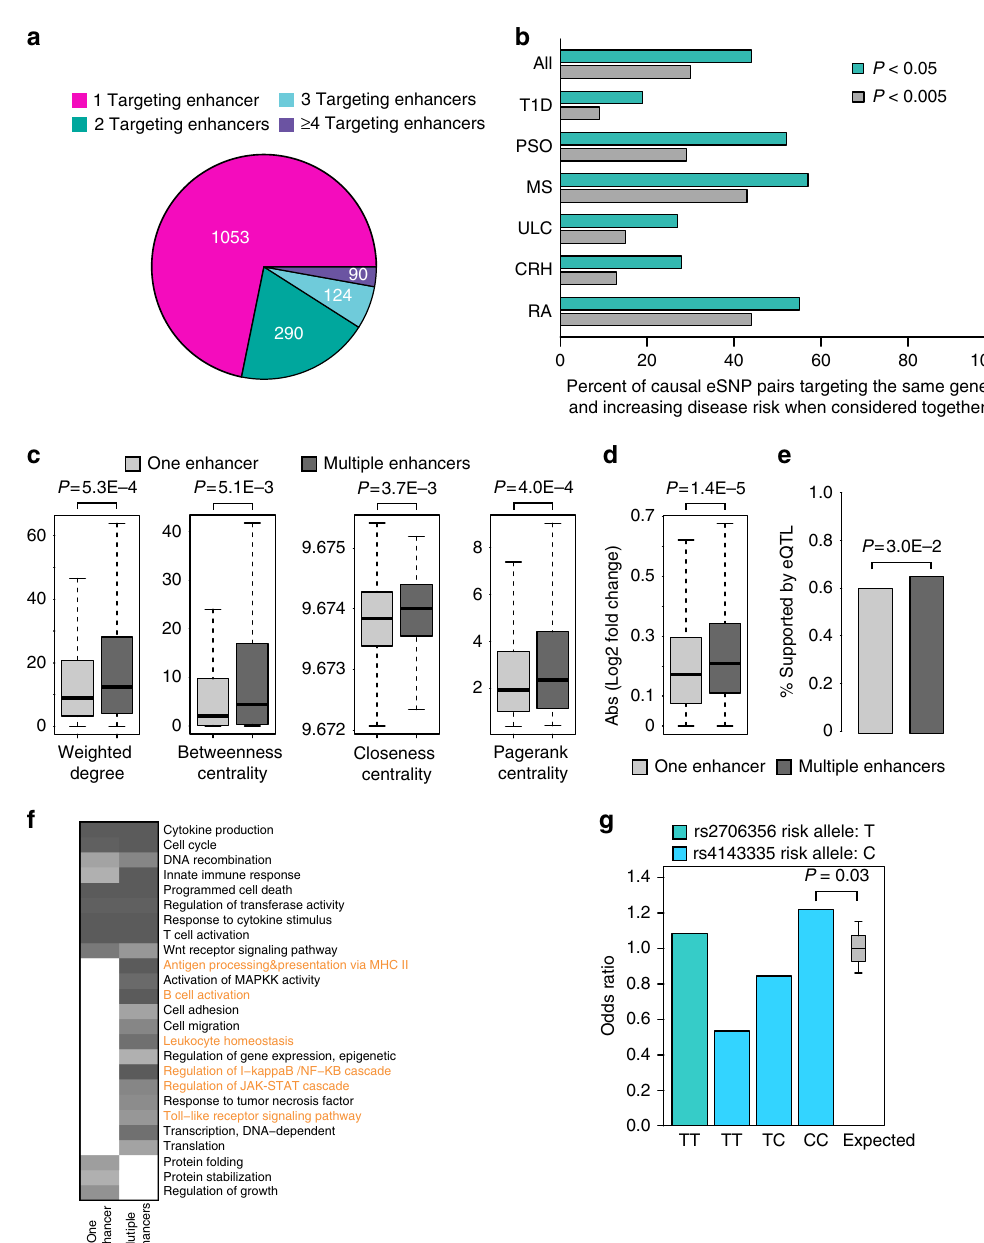
Fig. 5 Combinatorial risk noncoding mutations. a Number of genes that are targeted by different numbers of eSNP-containing enhancers. A considerable fraction of genes are targeted by multiple enhancers, suggesting combinatorial regulation of affected genes by multiple risk eSNPs. b Percentage of causal eSNP pairs that target the same gene and increase disease risk when considered together. Genes targeted by multiple risk eSNPs have higher values of network topological features ( c ), higher expression fold changes between case and control samples ( d ), higher overlap with eQTLs ( e ), and more enriched GO terms for immune responses (highlighted in orange) ( f ). g Odds ratio for all individuals homozygous at the eSNP r2706356 and odds ratios determined when homozygous individuals were strati fi ed based on the genotype of the co-targeting eSNP (rs4143335), as compared to the expected distribution of odds Figure 6a, b shows two example genes that are targeted by multiple risk eSNPs. IRF1 plays a critical role in regulatory T-cell function and autoimmunity 39 . It is targeted by two enhancers based on both IM-PET prediction and experimental Capture-Hi- C data in CD4 + T cells 40 . The two eSNPs (rs4143335 and rs2706356) signi fi cantly disrupt the binding of HNF4A and E2F1, respectively. Both E2F1 41 and POU2F1 42 have been shown to be + important transcriptional regulators of CD4 T-cell function. When we determined the clinical risk (odds ratio) for Crohn ’ s disease based on the genotype of both variants, we found an